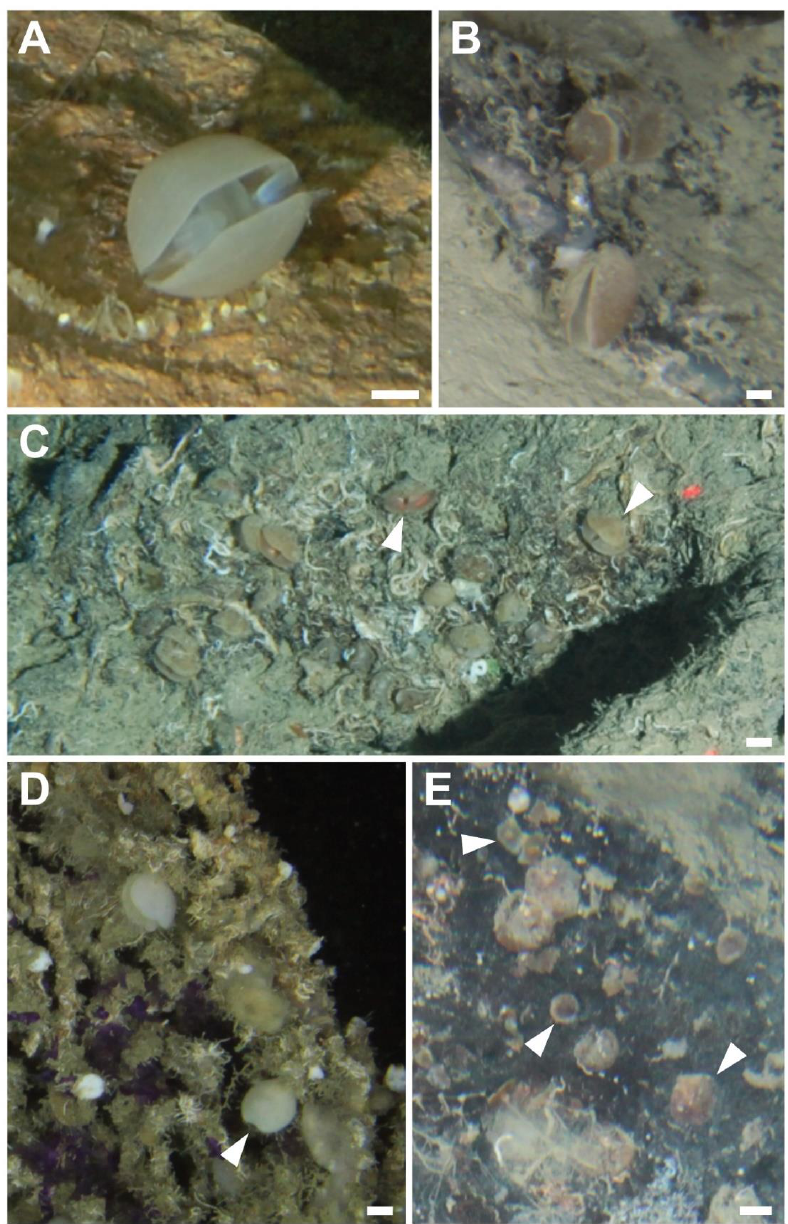
Figure 2. The four brachiopod species identified in the present study. ( A ) Gryphus vitreus , with its typical rounded valves and translucent-white colour (Capri Island, Gulf of Naples, southern Tyrrhenian Sea, 190 m); ( B ) G. vitreus with brownish valves on a rocky substate (Bordighera Canyon, western Ligurian Sea, 270 m); ( C ) aggregation of Megerlia truncata , with individuals protruding perpendicularly to the rock (Bordighera Canyon, western Ligurian Sea, 170 m); ( D ) specimens of Terebratulina retusa with the typical pear-shaped, white valves (Tavolara Canyon, North-eastern Sardinia, 185 m); ( E ) numerous individuals of Novocrania anomala with the brown dorsal valves, conical and roughly round shaped, attached to a rocky vertical wall (Bordighera Canyon, western Ligurian Sea, 360 m). Scale bar: 1 cm.